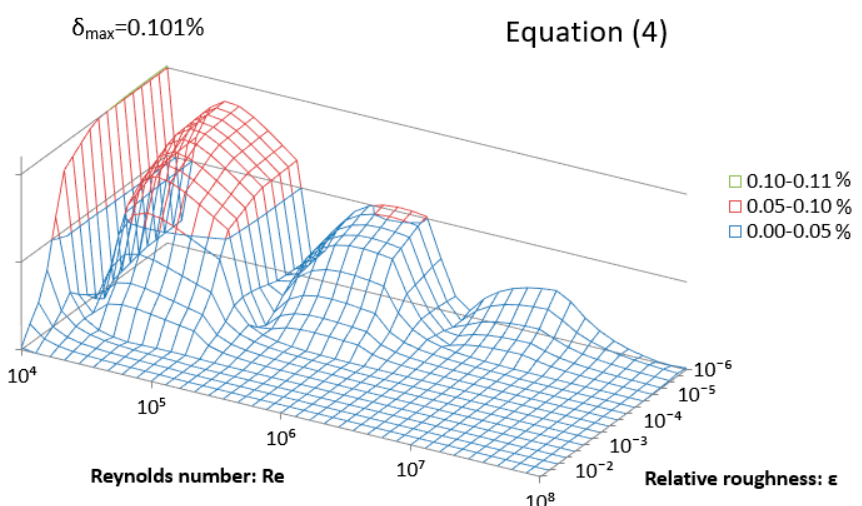
Figure 3. Distribution of the relative error for the approximation with one internal cycle and a starting point given by the rational function p o , Equation (2).